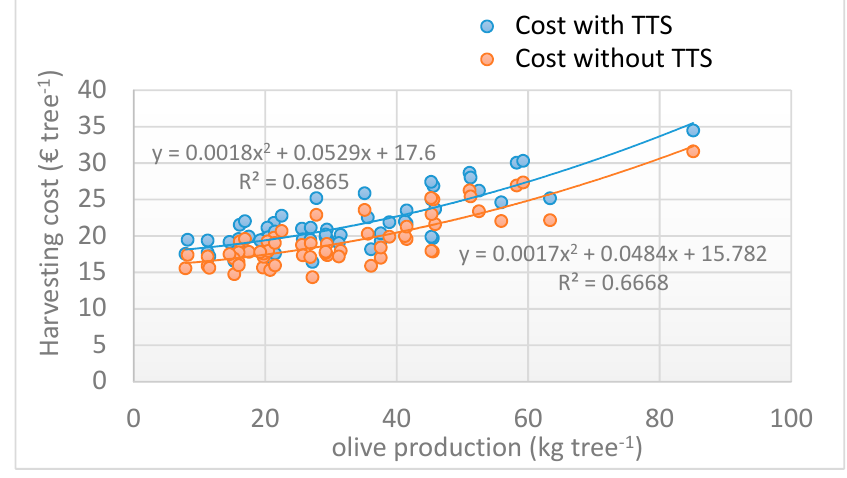
Figure 12. Harvesting cost with and without TTS application as a function of olive production per tree.